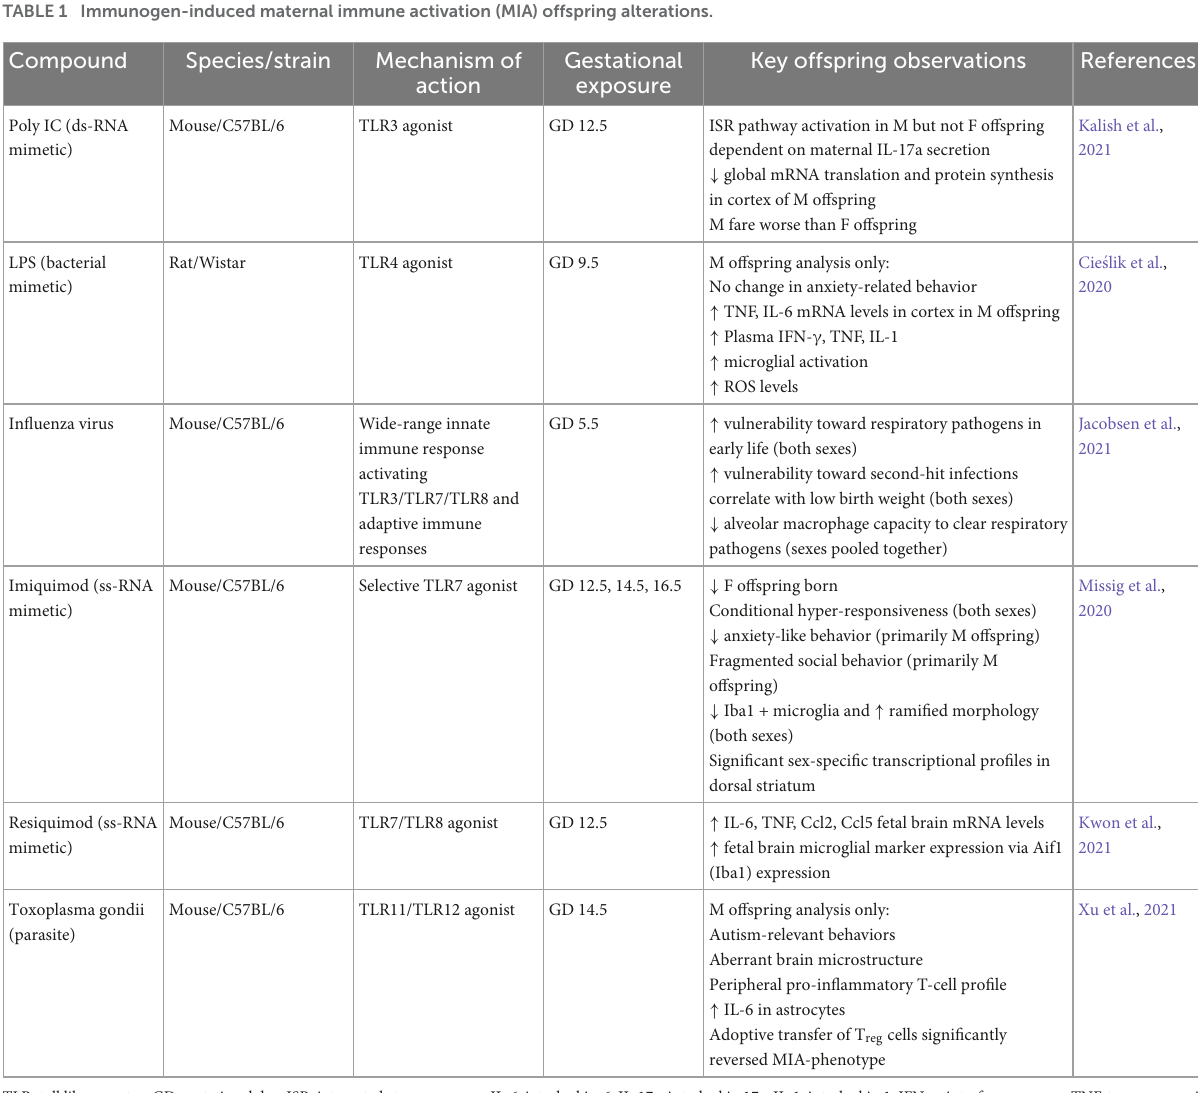
TABLE 1 Immunogen-induced maternal immune activation (MIA) offspring